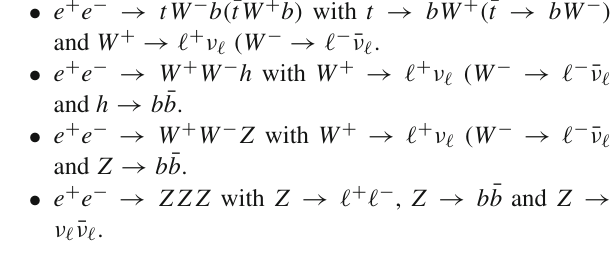
respectively. The numerical values of the input parameters are taken from